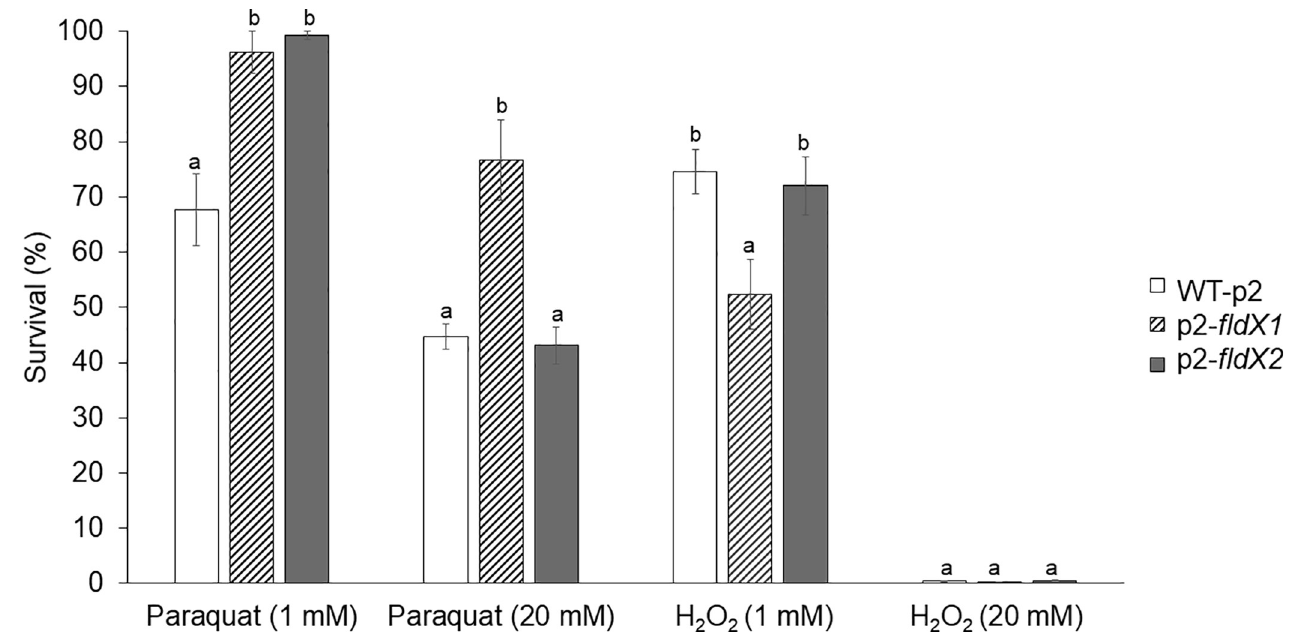
Fig 5. Effects of the flavodoxins on P . xenovorans survival after exposure to oxidizing agents paraquat and H 2 O 2 in liquid medium. Exponentially grown cells were exposed to paraquat or H 2 O 2 (1 and 20 mM) for 1 h. Aliquots were taken to determine colony-forming units (CFU). The percentage of survival was determined as the ratio of cells exposed to oxidizing agents and untreated cells. Significant differences were determined with a Tukey Test (p < 0.05) as indicated. Each CFU value is an average ± SD of at least three independent experiments.